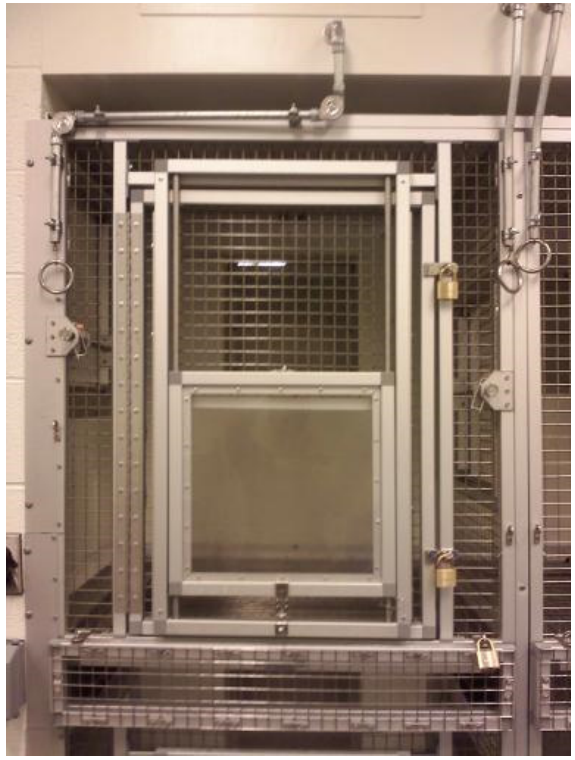
Figure 3. Photograph of one of the eight upper-level cubicles used in this experiment taken from the testing room. At the rear of the cubicle, the solid guillotine door leading to the capuchin enclosure is closed. At the front of the cubicle, the cubicle door consists of a stainless-steel mesh upper portion and a Plexiglas TM window that can be secured at several different heights.